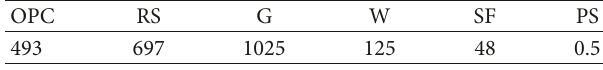
Table 3: Mixture proportions (kg/m 3 ) of normal